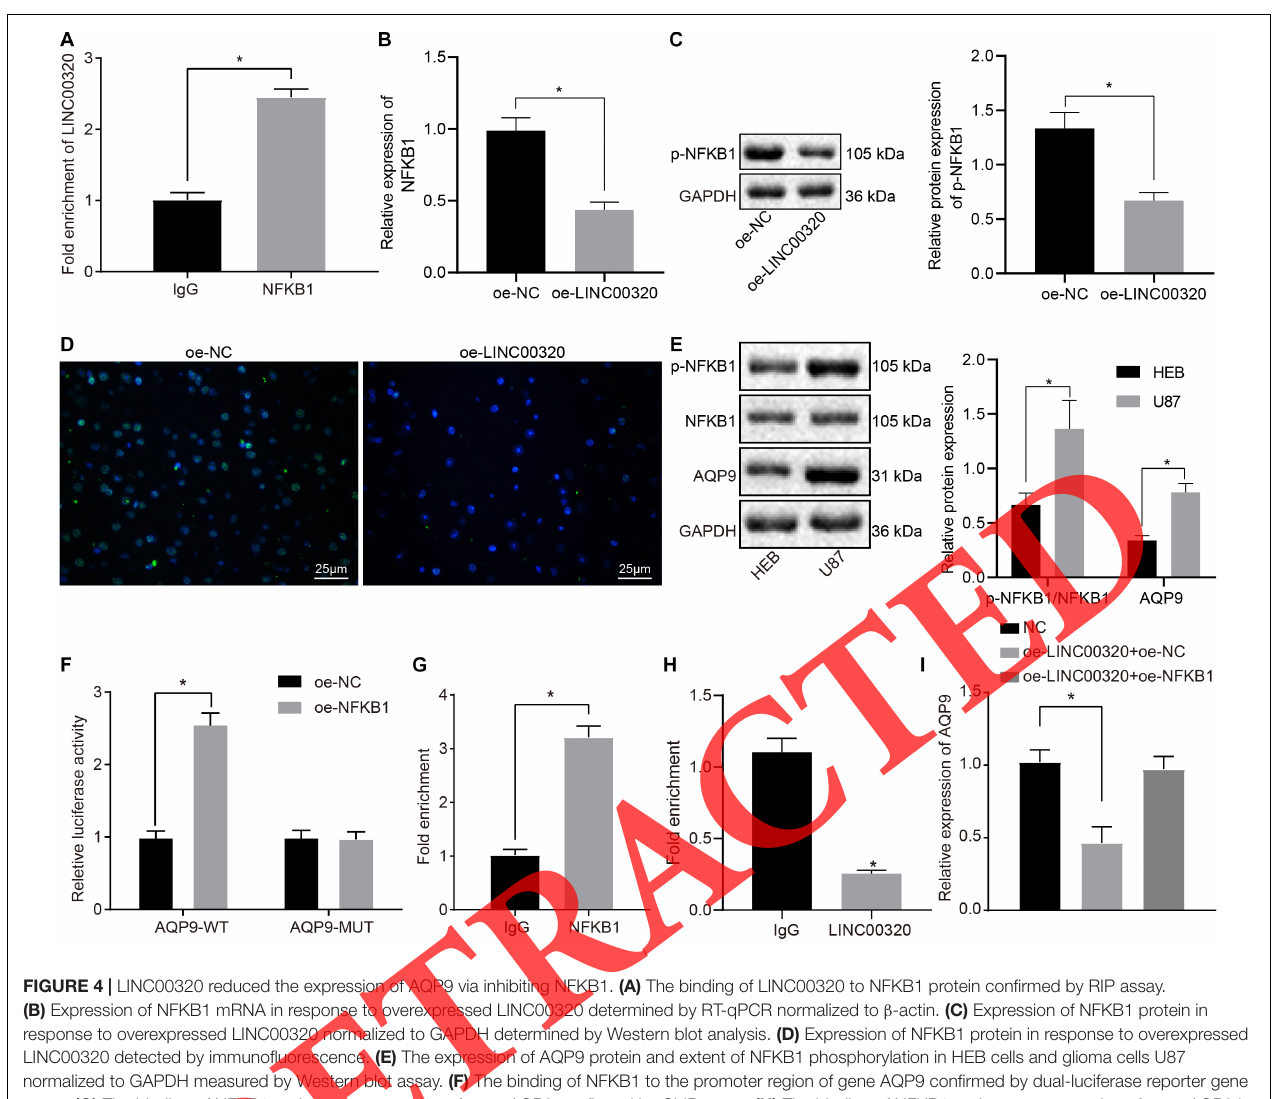
FIGURE 4 | LINC00320 reduced the expression of AQP9 via inhibiting NFKB1. (A) The binding of LINC00320 to NFKB1 protein confirmed by RIP assay. (B) Expression of NFKB1 mRNA in response to overexpressed LINC00320 determined by RT-qPCR normalized to β -actin. (C) Expression of NFKB1 protein in response to overexpressed LINC00320 normalized to GAPDH determined by Western blot analysis. (D) Expression of NFKB1 protein in response to overexpressed LINC00320 detected by immunofluorescence. (E) The expression of AQP9 protein and extent of NFKB1 phosphorylation in HEB cells and glioma cells U87 normalized to GAPDH measured by Western blot assay. (F) The binding of NFKB1 to the promoter region of gene AQP9 confirmed by dual-luciferase reporter gene assay. (G) The binding of NFKB1 to the promoter region of gene AQP9 confirmed by ChIP assay. (H) The binding of NFKB1 to the promoter region of gene AQP9 in response to overexpressed LINC00320 confirmed by ChIP assay. (I) The expression of AQP9 in transfected cells determined by RT-qPCR normalized to β -actin. * p < 0.05 vs. IgG, HEB cells, or oe-NC group. Data were expressed as mean ± standard deviation, and data between two groups were analyzed by independent-sample t test. Data among multiple groups were analyzed by one-way ANOVA, followed by a Tukey multiple-comparisons posttest. The experiment was repeated three times